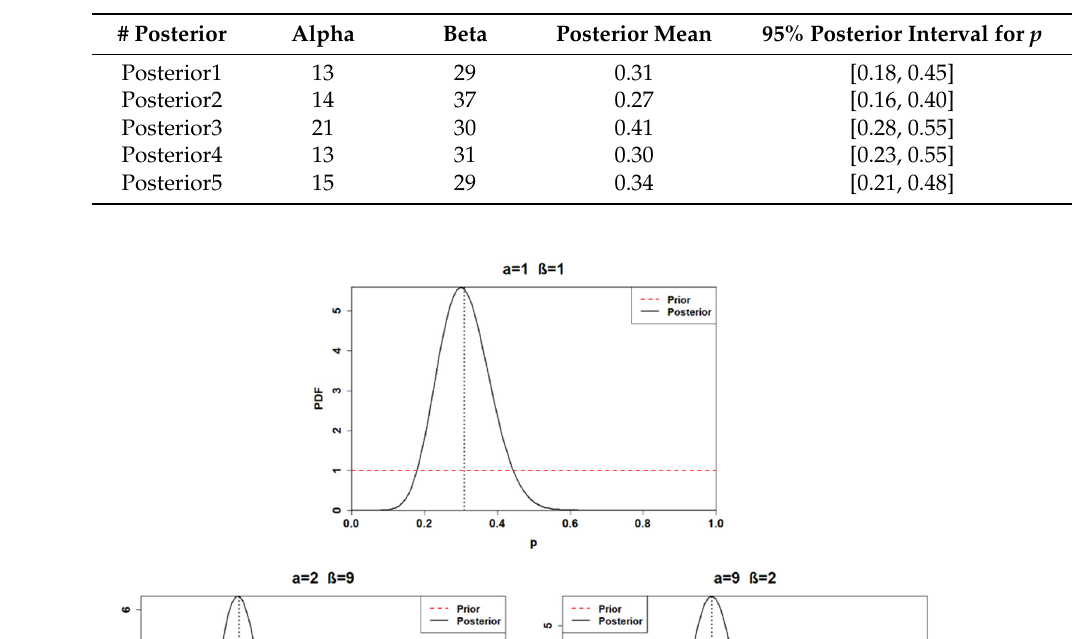
Table 5. Parameters of each posterior distribution for the third application (sample with n = 40, k = 12).